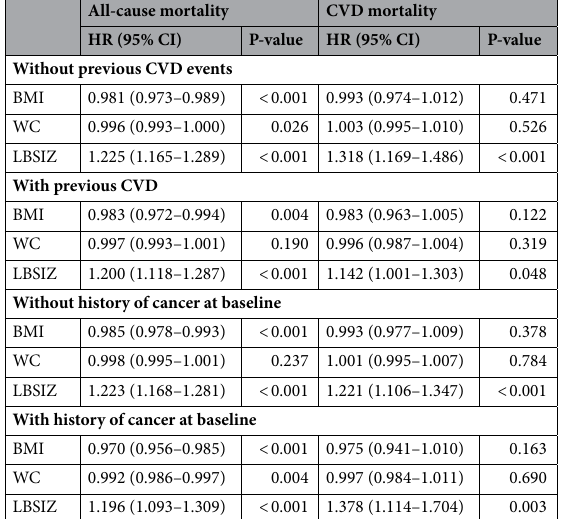
Table 4. Subgroup analysis of the association between each obesity parameter and mortality according to underlying diseases. Adjusted for age, sex, ethnicity/race, smoking status, alcohol consumption, history of cancer at baseline, diabetes mellitus, hypertension, dyslipidemia, and previous CVD event. BMI body mass index, WC waist circumference, LBSIZ z-score of the log-transformed A Body Shape Index, CVD cardiovascular